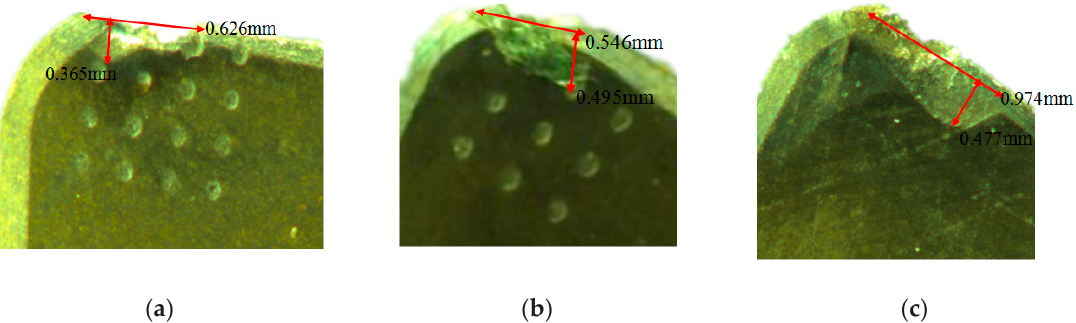
Figure 9. The micrograph of tool wear: ( a ) d = 80 µm micro-hole tool; ( b ) d = 120 µm micro-hole tool; ( c ) non-textured tool.